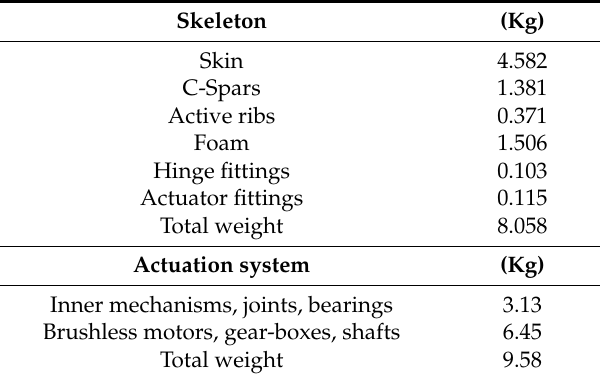
Table 3. Multifunctional twistable wing trailing-edge: weight breakdown.